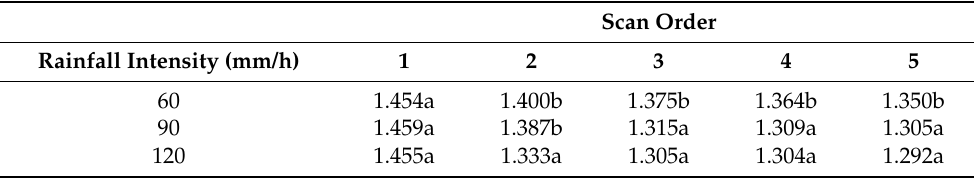
Table 1. Fractal dimensions of networks on the surface after each rainfall event (LSD (least significant difference) test was conducted between three rainfall intensity